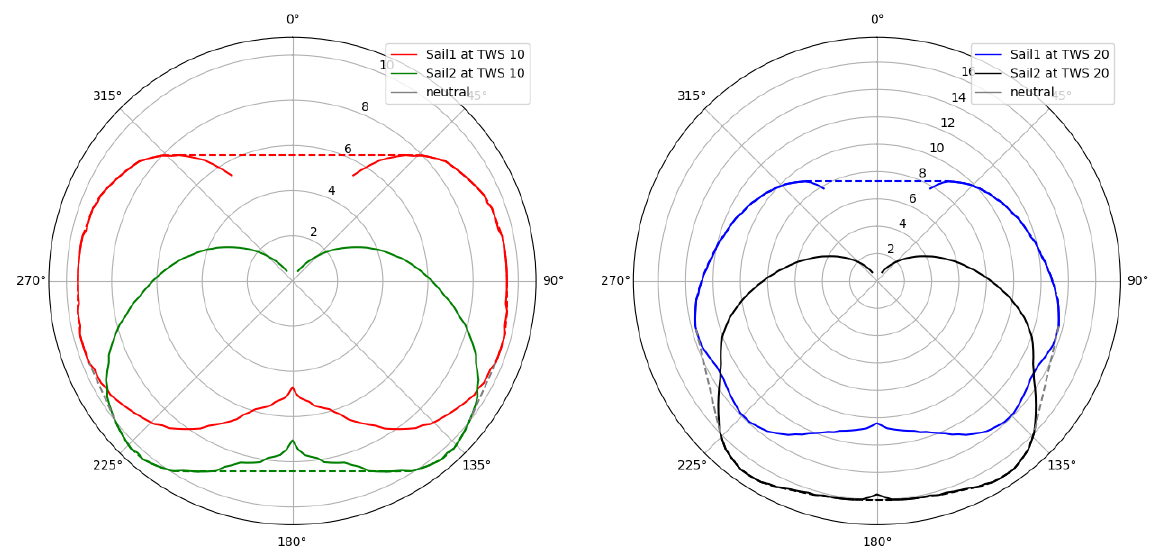
Figure 9. A polar plot of the combined convex hull (dashed lines) of polar diagram slices of multiple sails (solid lines). Dashed lines corresponding to a single sail (same color) indicate manoeuvres without sail changes. Grey dashed lines indicate manoeuvres with sail